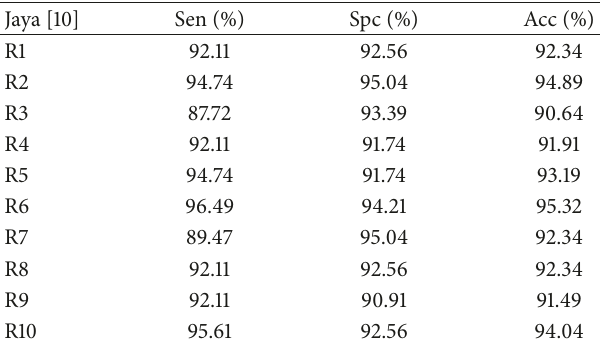
Table 8: Results of 10 × 10-fold cross validation of plain Jaya algorithm [10].